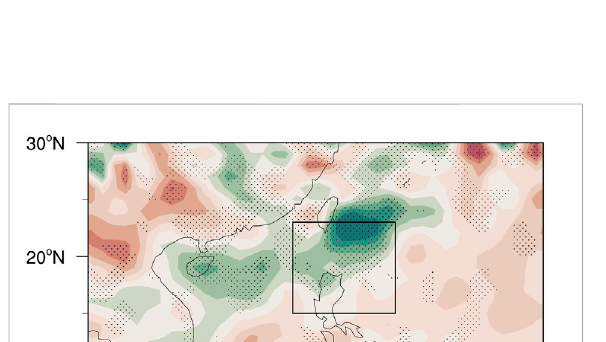
Low-latitude key region